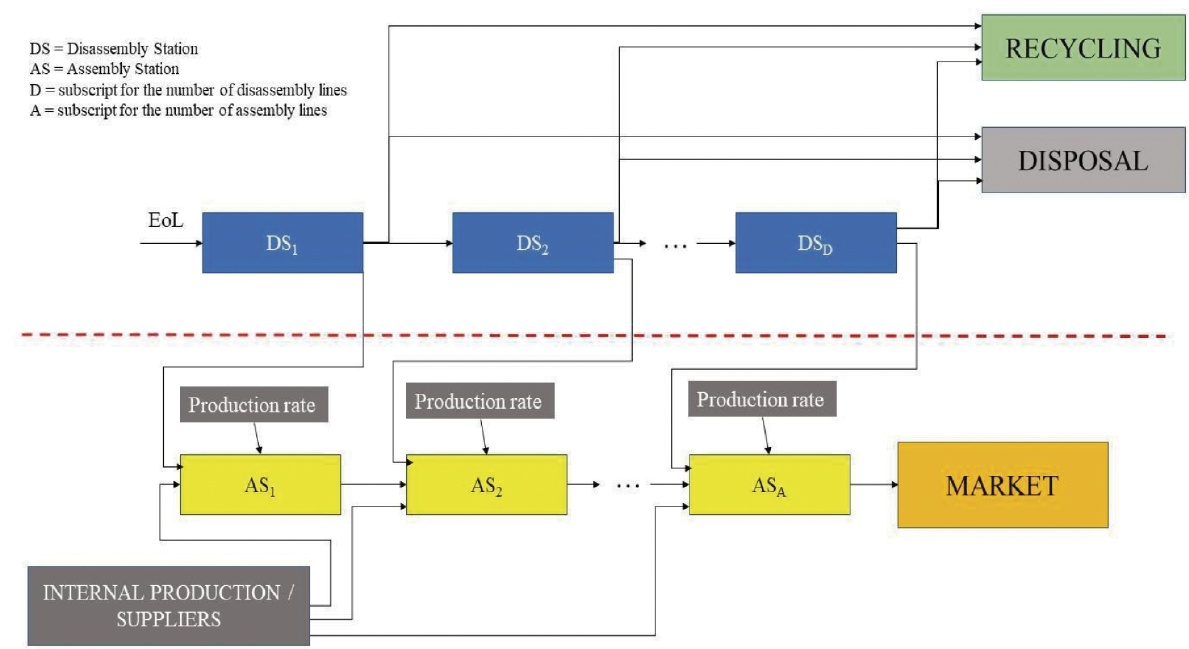
Figure 2. Assembly/disassembly lines (Sergio et al., 2021)